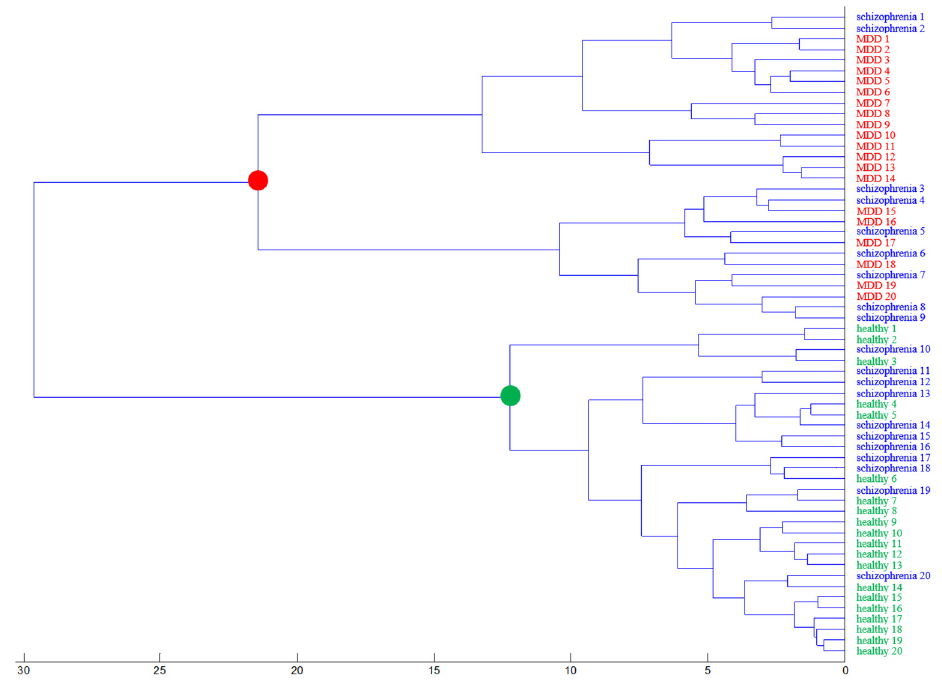
Figure 6. Results of hierarchical clustering analysis based on PCA results.